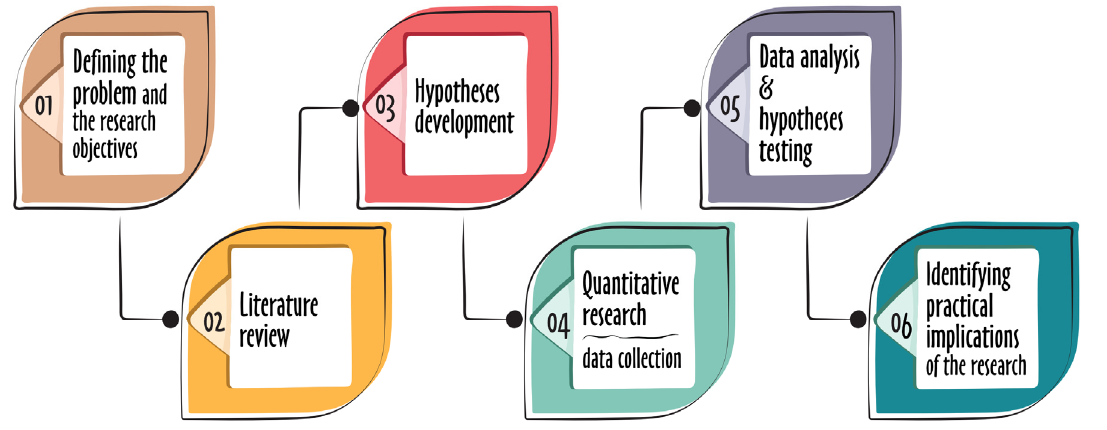
Figure 1. The methodological process. Source: own work.